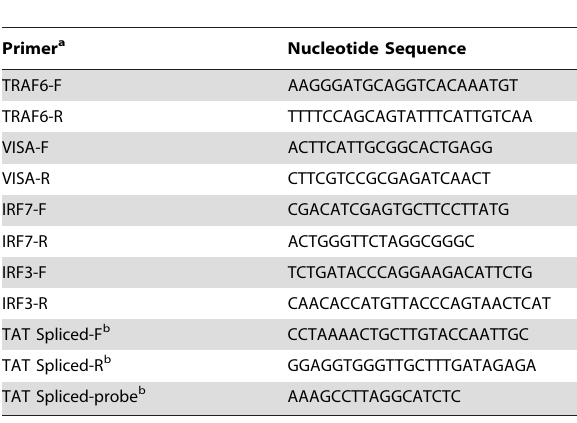
Table 4. Sequence of Oligonucleotide Primers used in Real- Time qRT-PCR Gene Expression